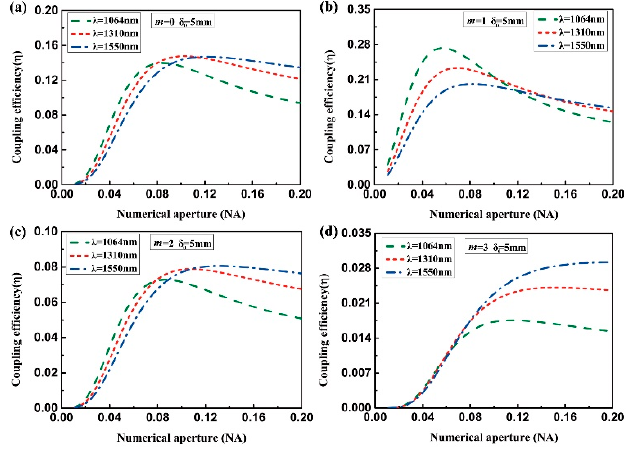
Figure 5. The coupling efficiency of the beam with δ 0 = 5 mm, ω 0 = 10 mm versus numerical aperture for different wavelengths λ under different topological charges.